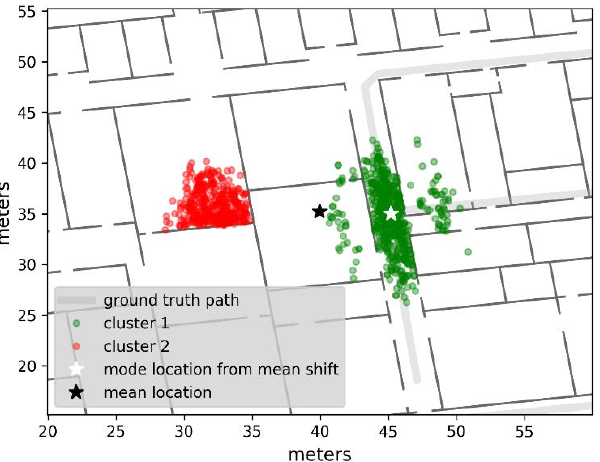
Figure 5. The set of particles at a certain time during tracking. Note that the particles are distributed in two main clusters (shown in different colors). The mean particle location (posterior mean), shown by a black star, is in an incorrect position. The highest mode of the distribution, as found by mean shift, is shown by a white